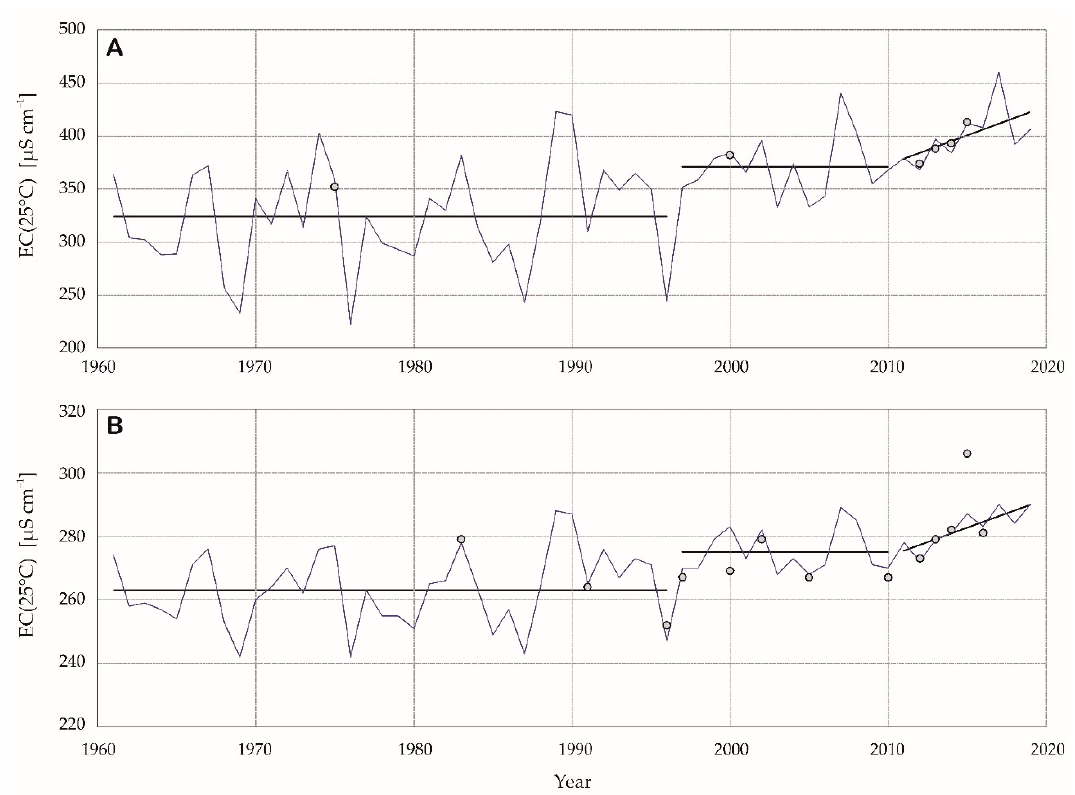
Figure 6. Multiannual dynamics of the mean surface water conductivity of all SLP lakes ( A ) and Lake Ha ń cza ( B ) calculated from climatic models (Table 4). Circles mark the observed data. Black lines denote multiannual averages and trend lines in the last decade.